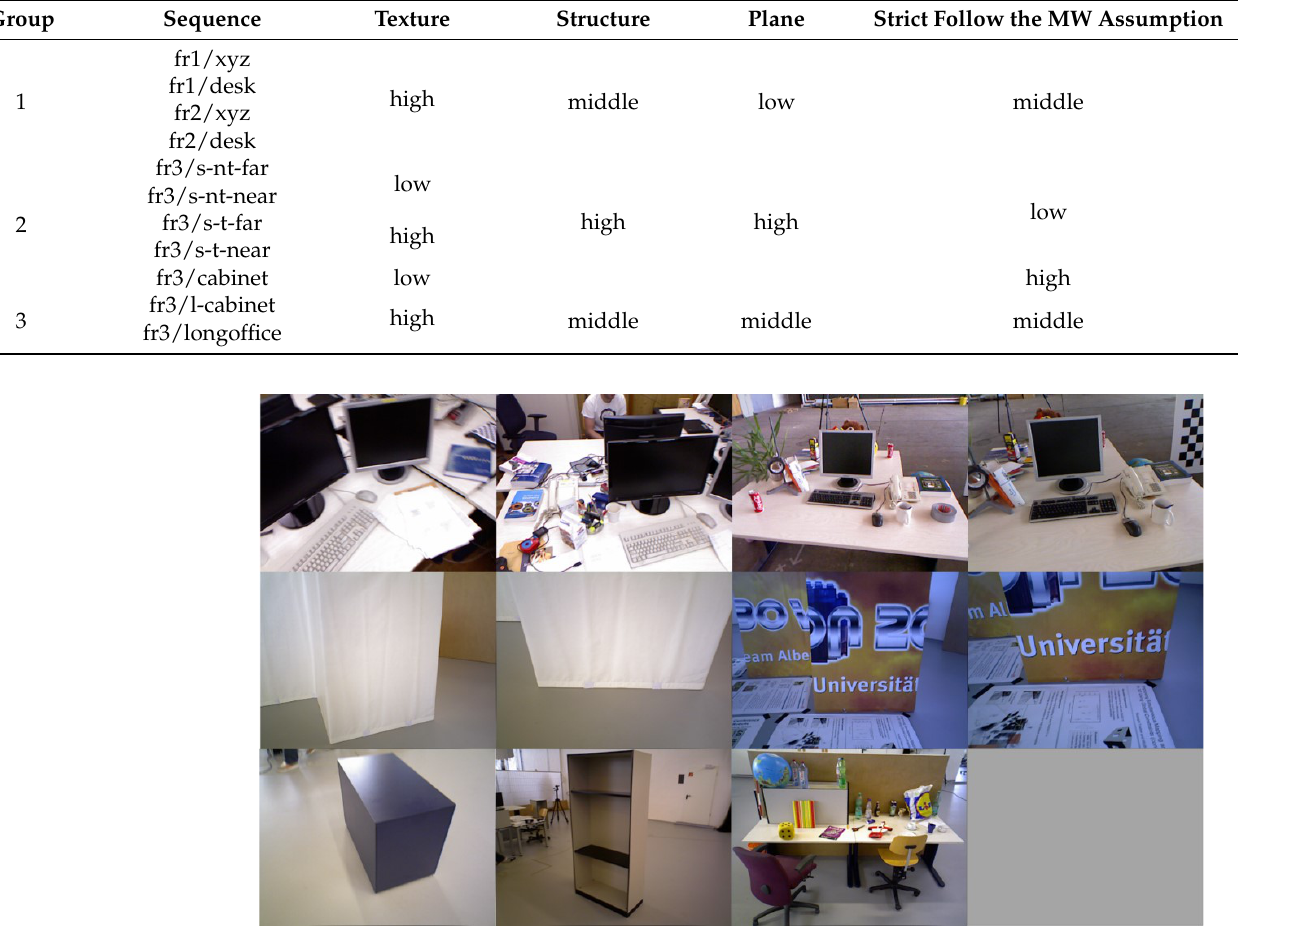
Figure 7. Sequences in TUM RGB-D dataset. The sorting is consistent with that in Table 3.